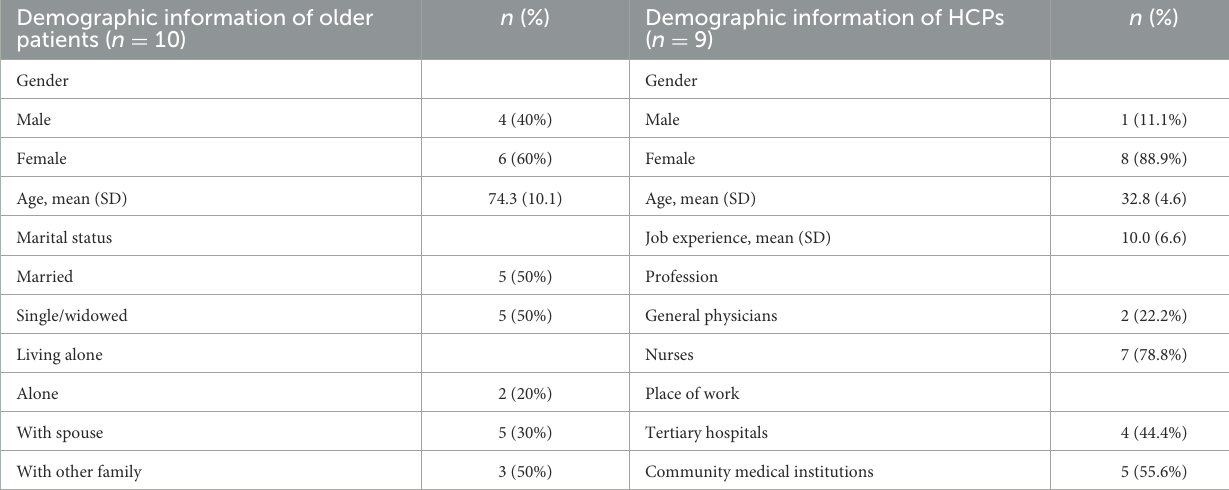
TABLE 2 Demographic characteristics of the older patients and HCPs. Demographic information of older patients ( n =